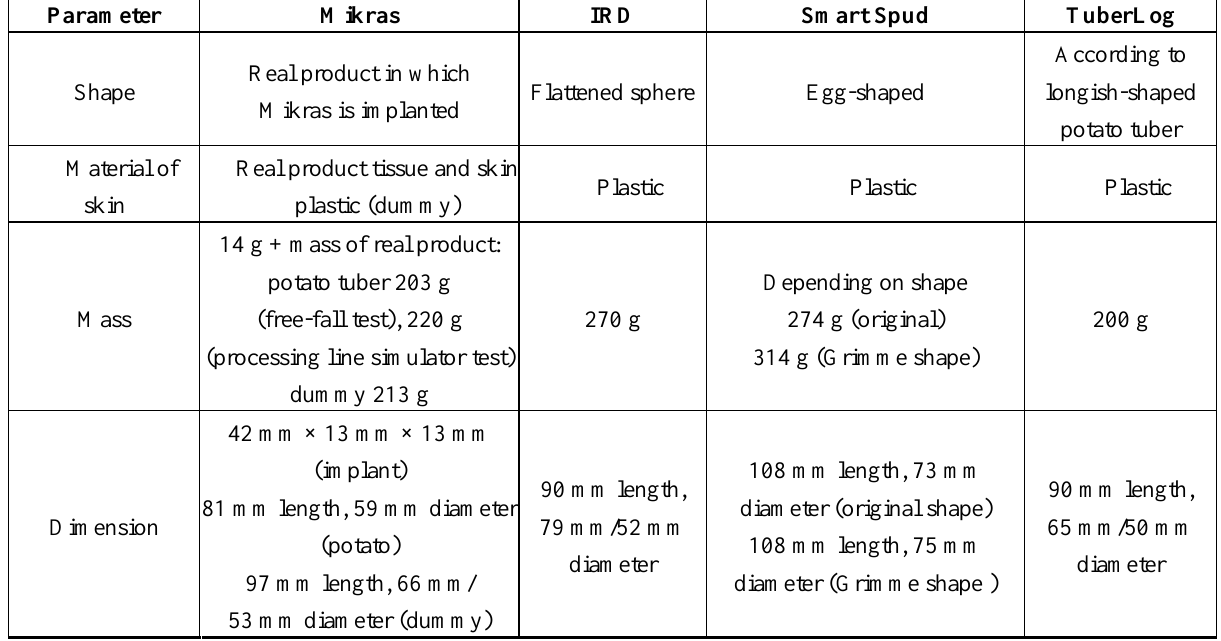
Table 1. Different measuring devices with selected specific settings for the application in this